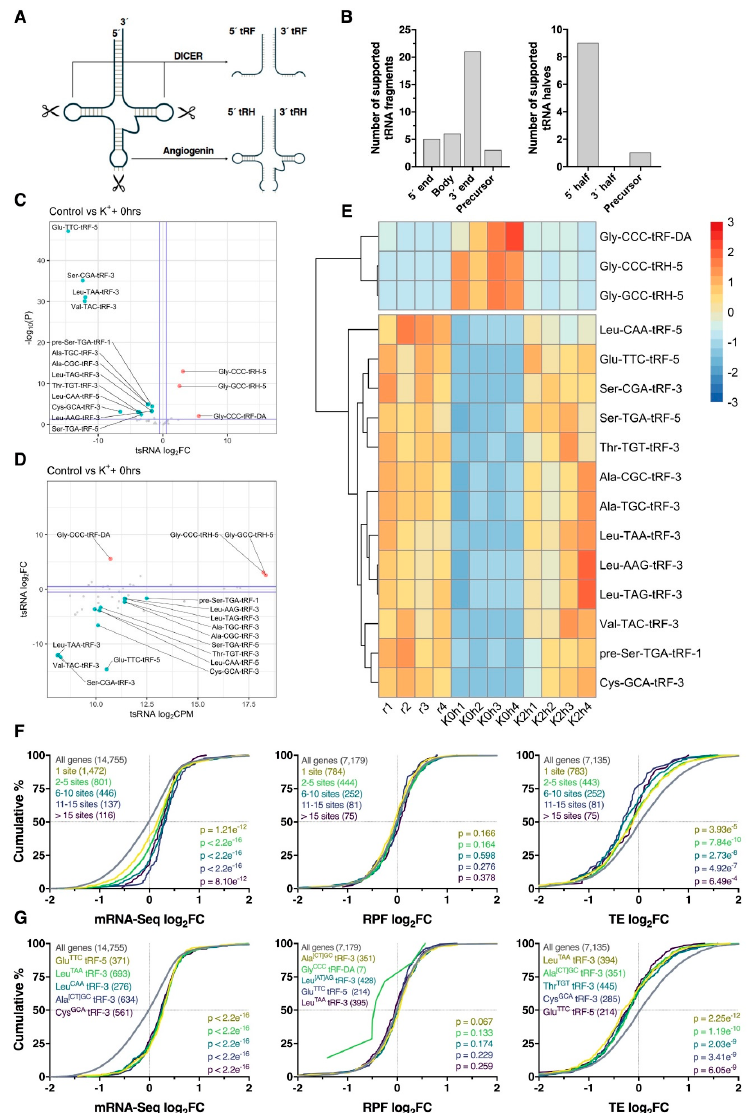
Figure 7. Differential processing of tRNA-derived small RNA fragments. ( A ) Schematic overview of cleavage sites required for processing of tRNAs into ~14–30 nt tRNA-derived fragments (tRFs) and ~28–36 nt tRNA-derived halves (tRHs; also known as tiRNAs). ( B ) Bar plots summarizing the locations at which tsRNAs were cleaved from mature tRNAs or precursor tRNAs. ( C ) Volcano plot comparing log 2 fold change (log 2 FC) and –log 10 p -values for tsRNAs immediately after the depolarization paradigm. Note the bias towards downregulation of tRFs. Significantly upregulated and downregulated tsRNAs are marked in red and blue, respectively, with Benjamini–Hochberg FDR < 0.05 and log 2 FC > | ± 0.5 | considered significant. Horizontal line represents nominal p < 0.05. Suffixes denote location of origin (1 = 5 (cid:48) precursor sequence, 3 = 3 (cid:48) mature sequence, 5 = 5 (cid:48) mature sequence and DA = mature tRNA D and A loops). ( D ) Scatter plot comparing tsRNA log 2 FC and average counts per million (CPM). ( E ) Heat map depicting tsRNA CPM across all samples for significantly regulated tsRNAs identified in panel ( C ). Each cell corresponds to the CPM standard deviation relative to the row-wise mean, with red corresponding to high expression, and blue to low expression. ( F ) Cumulative distribution profiles of mRNAs collectively targeted by all significantly downregulated tRFs, after stratifying for the number of predicted binding sites. Groups were compared to the entire transcriptome via two-sided Kolmogorov–Smirnov test, with p -values reported (bottom right). ( G ) As in ( F ), except stratified for targets of individual tRFs rather than analyzing them in combination. Top five tRFs ranked via significance are shown. In the case of p -value ties, tRFs with the largest median difference relative to genes with no binding site were